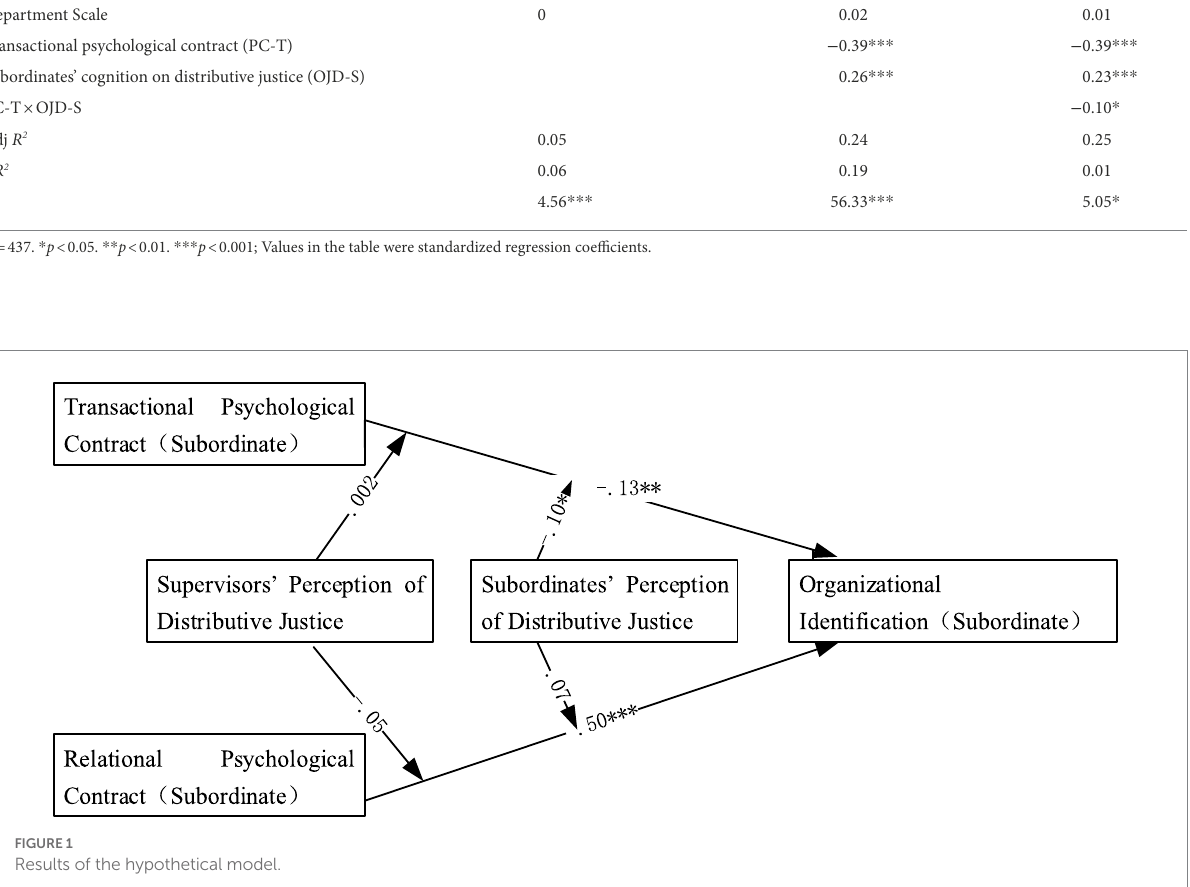
FIGURE 1 Results of the hypothetical model.